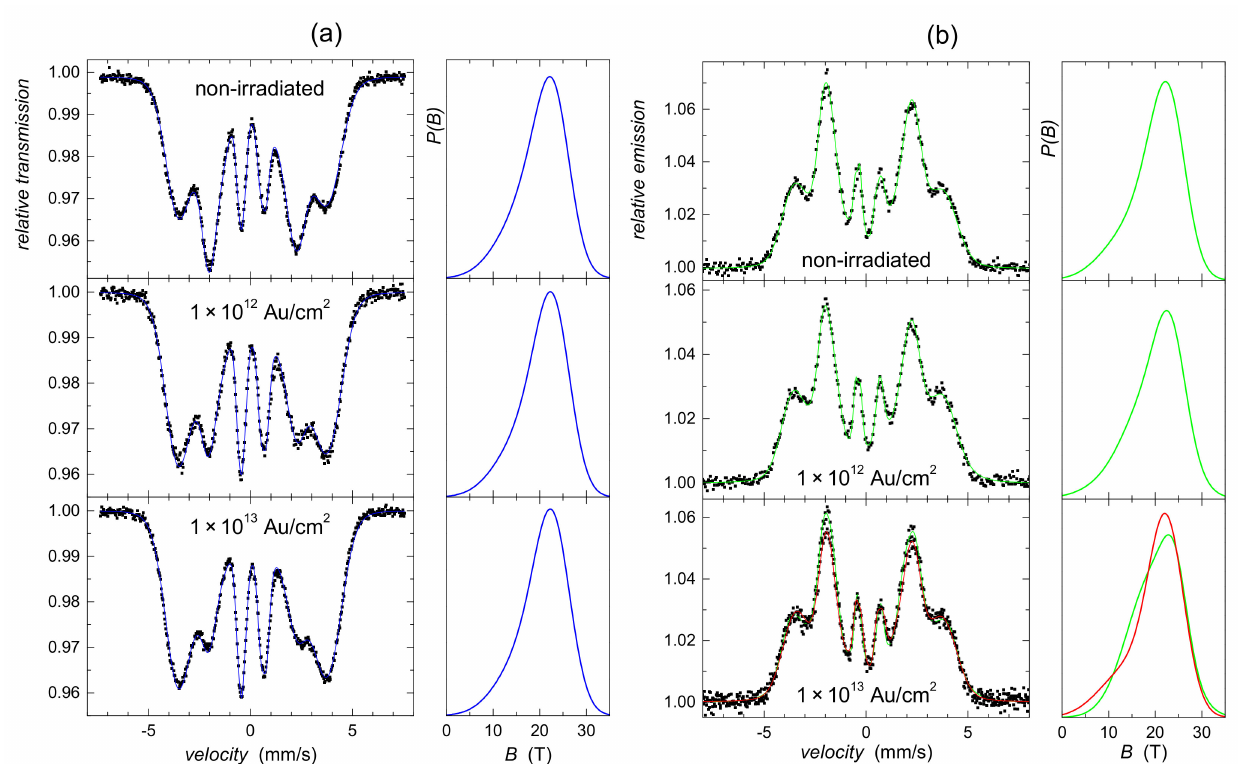
Figure 21. Mössbauer spectra (left-hand panels) and corresponding P ( B ) distributions (right-hand panels) of Fe 74 Cu 1 Nb 3 Si 16 B 6 amorphous metallic alloy irradiated by 593 MeV Au ions with the indicated fluences: ( a ) transmission geometry (blue); ( b ) CEMS (green). Mössbauer spectrum taken from the wheel side of the ribbons is shown for comparison in ( b ) together with the corresponding P ( B )